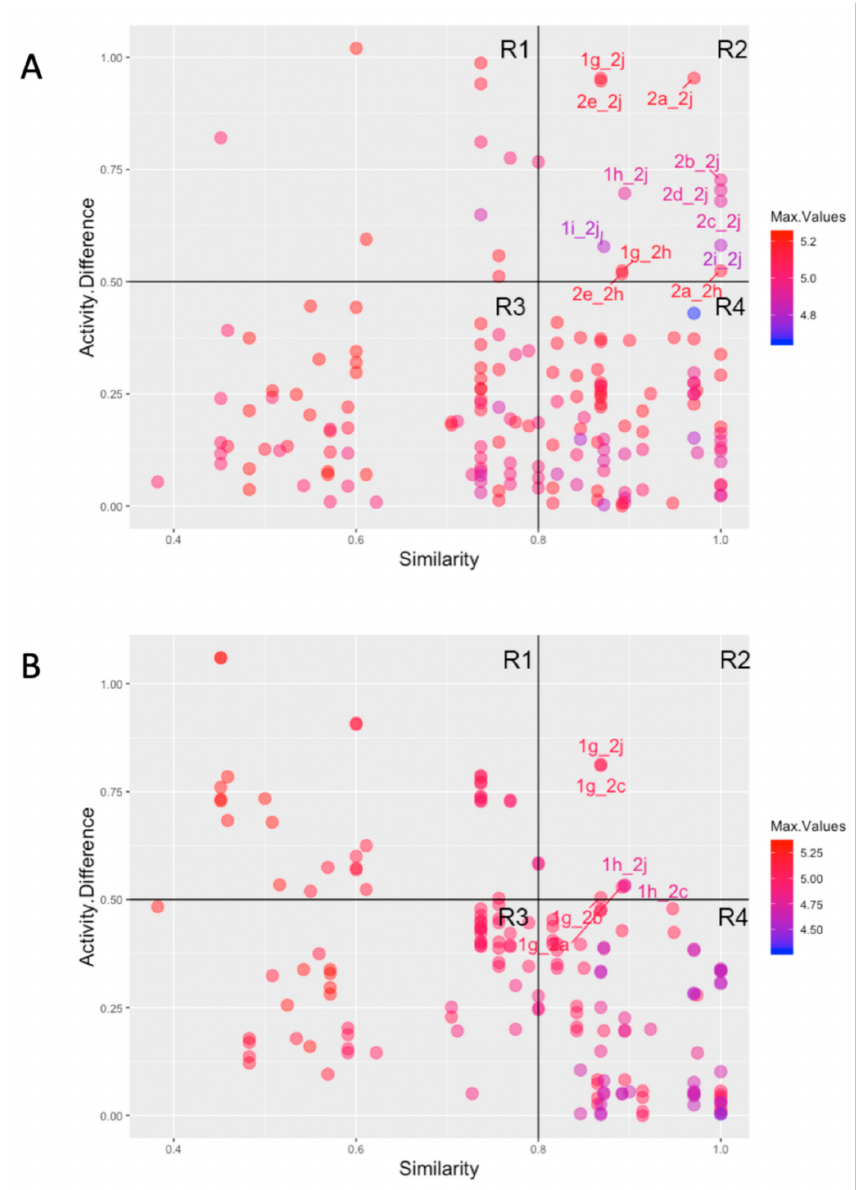
Figure 1. Structure-activity similarity maps (SAS maps) for T. cruzi based on chemical structure and biological activity. SAS maps against trypomastigote ( A ) and intracellular amastigote ( B ) forms of T. cruzi . Each point represents a pairwise comparison of 1,4-naphthoquinones derivatives. The points are colored to pIC50 values using a continuous scale from low (blue) to high (red) power. R1 = not descriptive; R2 = similar structure and different activity (Cliff activity); R3 = Different structure and similar activity (Similarity cliff) and R4 = Similar structure and activity (Smooth